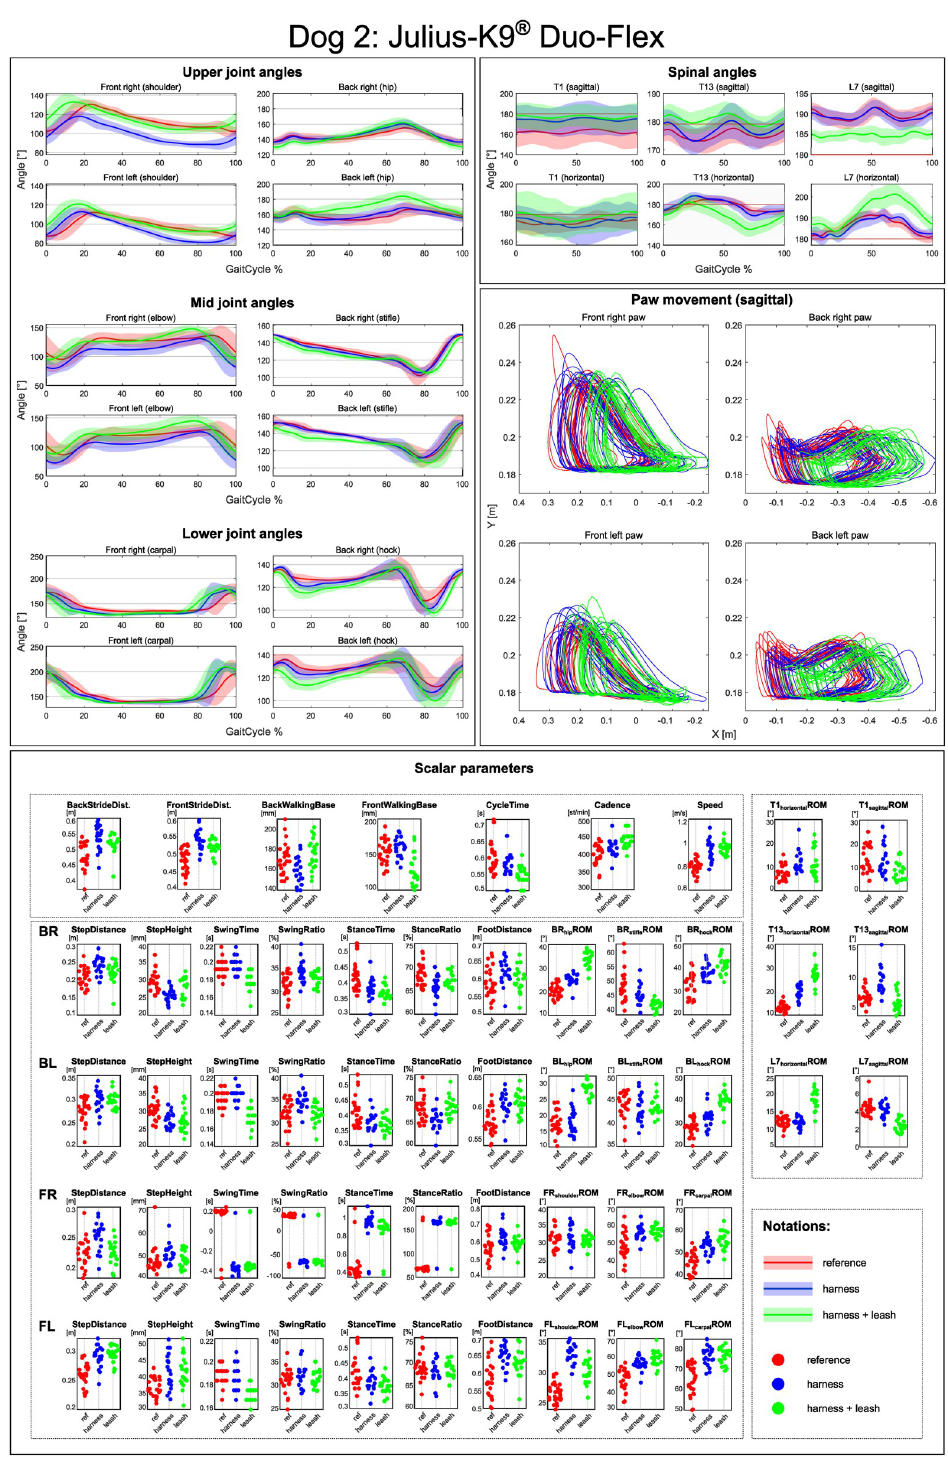
Fig 8. An example of a report comparing free movement with harness and harness + leash scenarios.